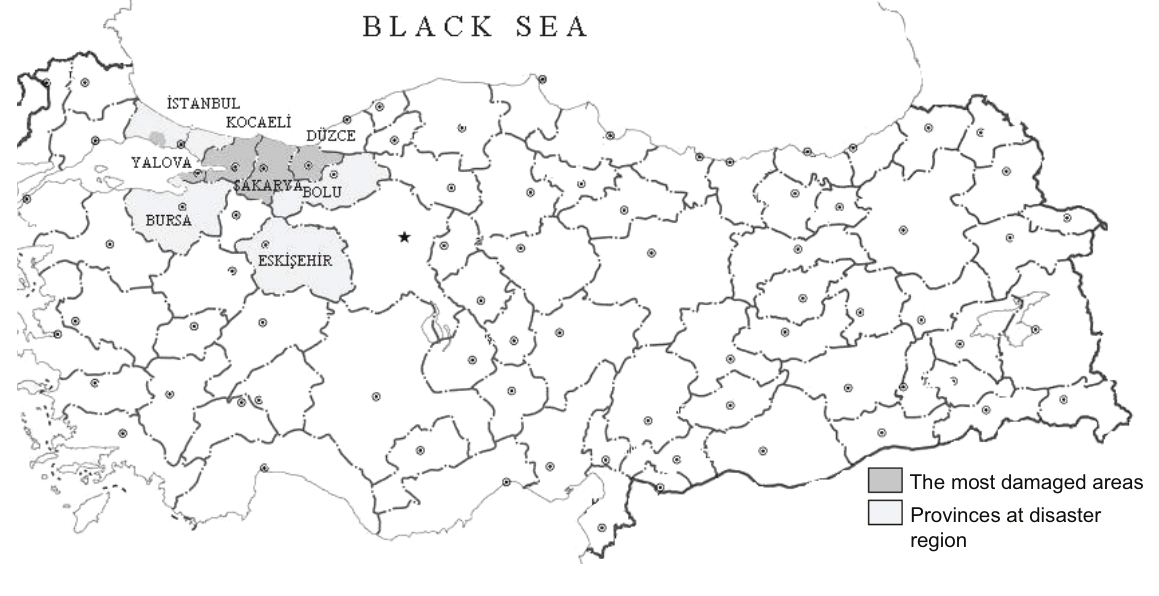
figure 1. location of provinces damaged